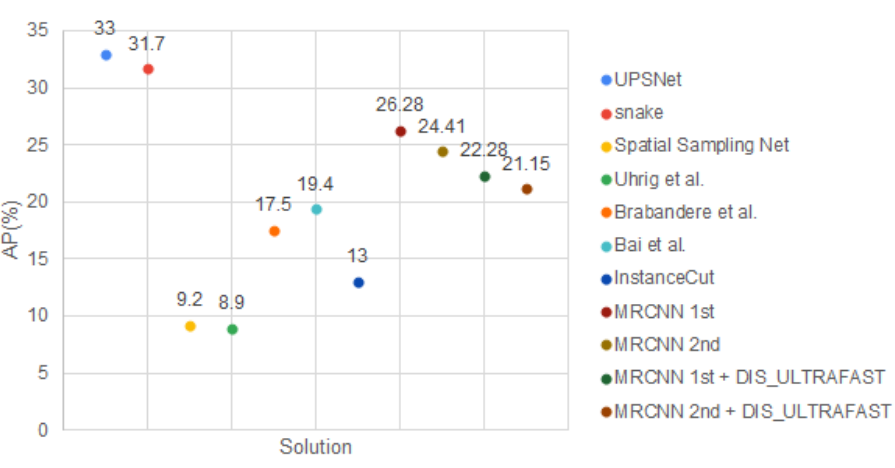
Figure 13. Comparison between our framework and other solutions (AP%), Cityscapes dataset [2].